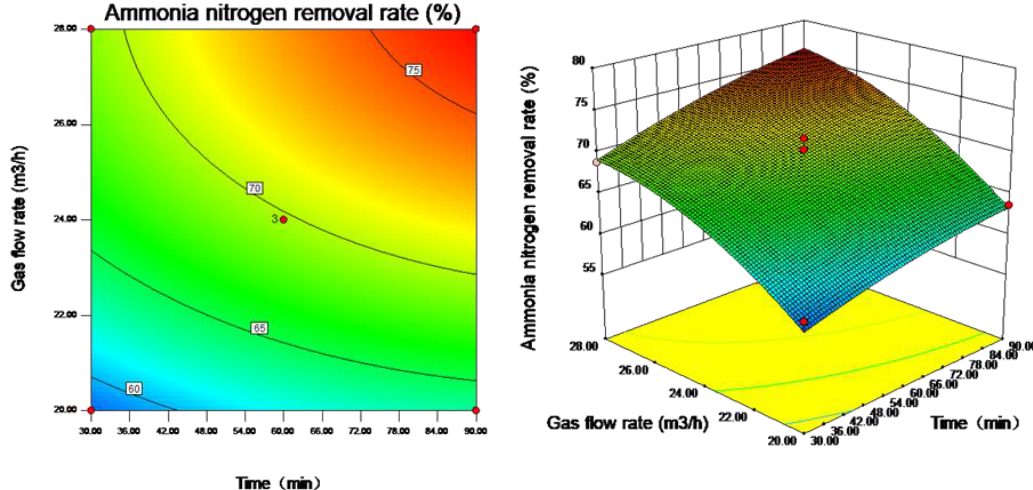
Figure 6. Contour plot and response surface plot of the effect of stripping time and gas flow rate on ammonia nitrogen removal rate.